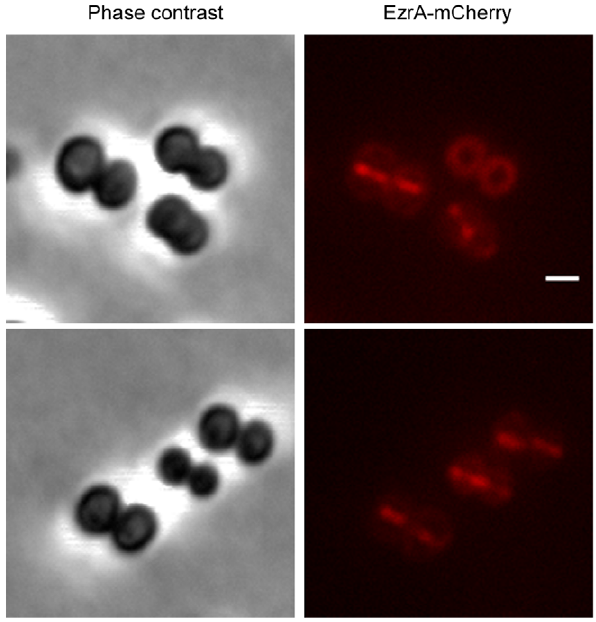
Figure 3. EzrA-mCherry localizes to the division septa of S. aureus . Phase contrast (left panels) and fluorescence (right panels) images of BCBAJ025 cells (NCTC8325-4 ezrA :: ezrA-mCherry ) expressing EzrA-mCherry fusion. Scale bar 1 m m.